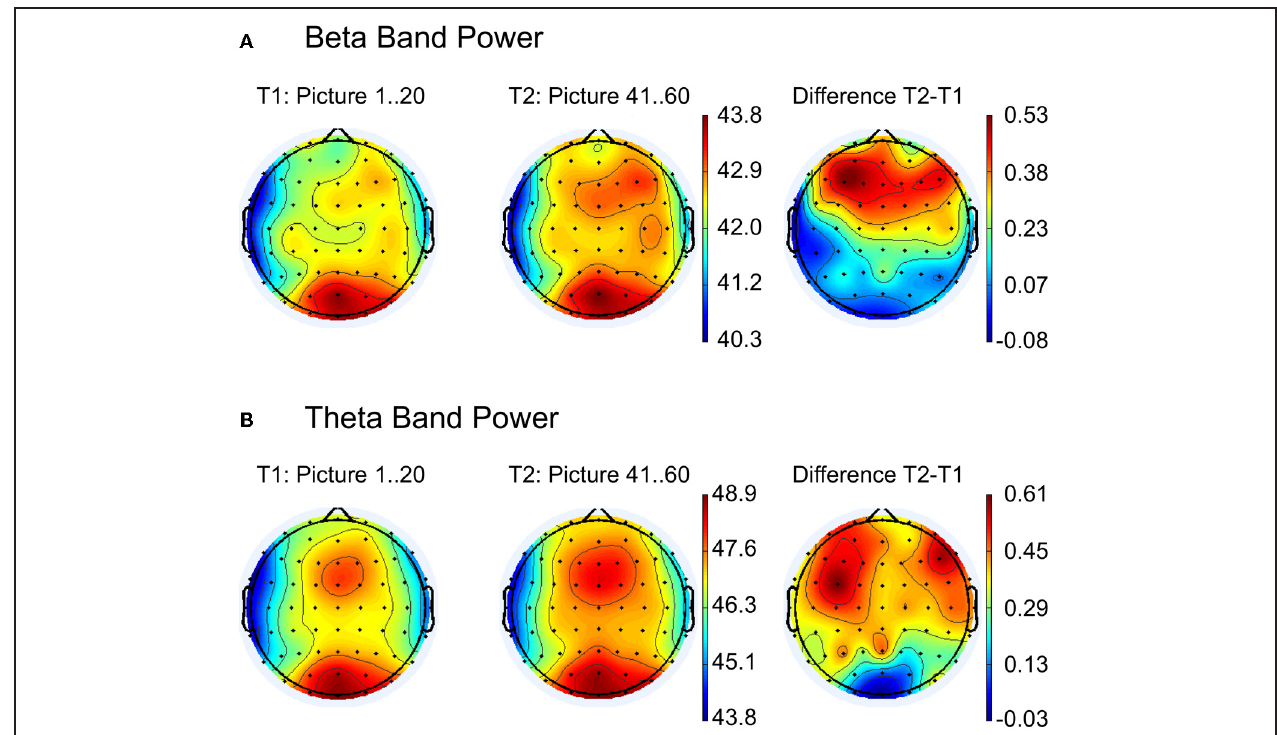
FIGURE 3 | Topographic maps for comparison between the first (T1) and the last (T2) 20 pictures for (A) beta and (B) theta band power. The right column shows the difference maps T2 − T1. Strongest activity for beta and theta band is visible at the occipital